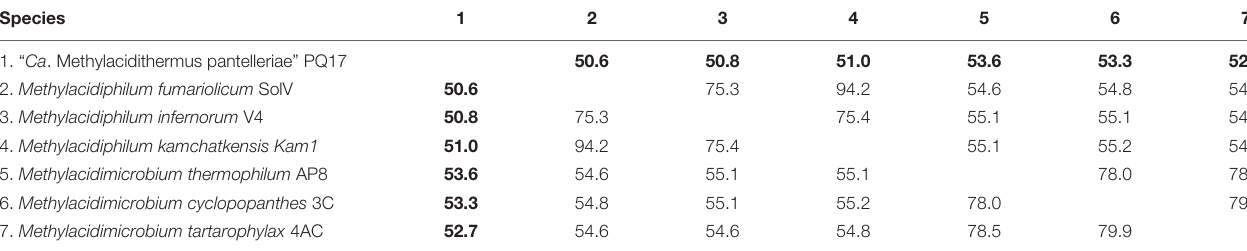
FIGURE 1 | 16S rRNA gene-based phylogenetic tree of methanotrophic Verrucomicrobia. The evolutionary history was inferred using the Neighbor-Joining method. The optimal tree with the sum of branch length = 0.41438253 is shown. The percentage of replicate trees ( > 50%) in which the associated taxa clustered together in the bootstrap test (500 replicates) are shown next to the branches. The tree is drawn to scale, with branch lengths in the same units as those of the evolutionary distances used to infer the phylogenetic tree. The evolutionary distances were computed using the Maximum Composite Likelihood method and are in the units of the number of base substitutions per site. The analysis involved 17 nucleotide sequences. All ambiguous positions were removed for each sequence pair. There were a total of 1,575 positions in the final dataset. Evolutionary analyses were conducted in MEGA7 (Kumar et al., 2016). TABLE 1 | Average amino acid identity (AAI) value comparison between different verrucomicrobial methanotroph species.